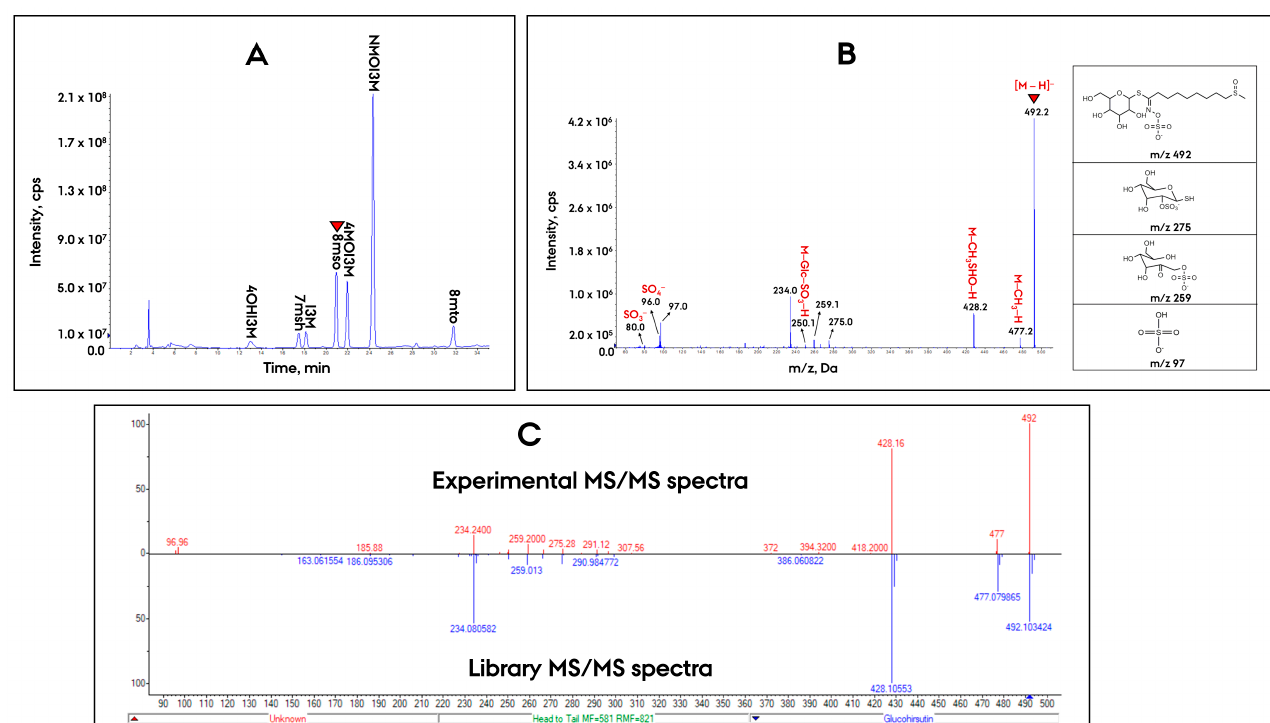
Figure 4. Chromatogram and mass spectra used for the tentative identification of 8-methylsulfinyloctyl glucosinolate (8mso) in Kin-0 root crude extract using the prec97-IDA-EPI method. ( A ) Total ion chromatogram (TIC) of the precursor ion scan was acquired by the data-dependent analysis from Prec97-IDA-EPI. ( B ) EPI scan of the fragmentation profile of 8mso ( m / z 492). ( C ) The head-to-tail comparison of EPI generated MS/MS spectra of [M − H] − at m / z 492 (red peaks in the top spectrum) from the Arabidopsis root extract against the library spectra from the Mass Bank of North America (MoNA) (blue peaks in the bottom spectrum).